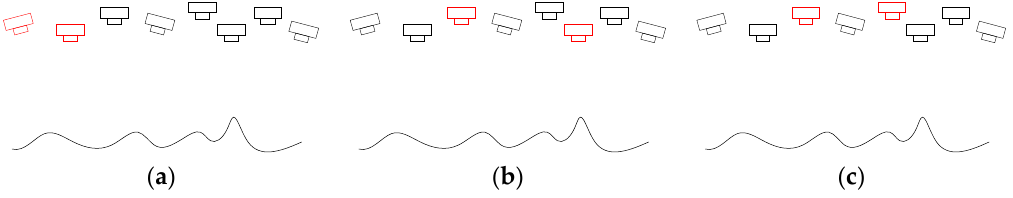
Figure 3. Choosing cameras corresponding to the initial image pair based on different methods. ( a ) The initial image pair is not closely related to the positions of other moments’ cameras; ( b ) The position between the cameras of the two moments corresponding to the initial image pair is too far; ( c ) Appropriate choice.